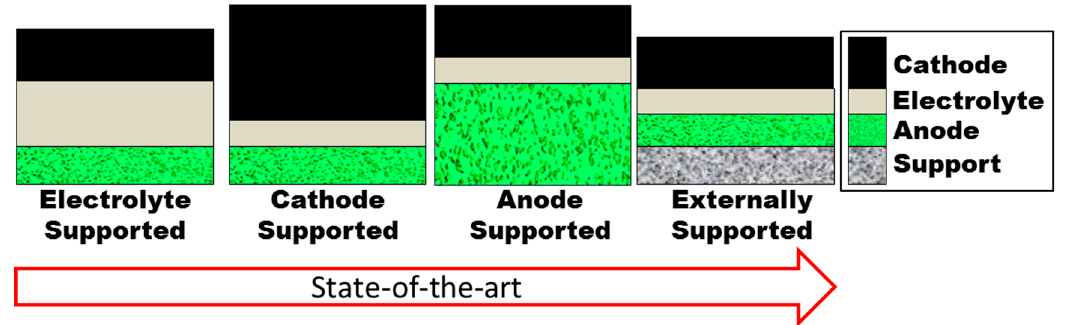
Figure 4. Tubular (and planar) SOFC cell support configurations and the progression of the state of the art. The distinguishing characteristics of planar versus micro-tubular SOFCs are seen in